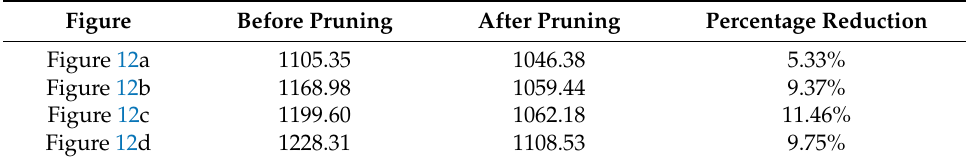
Figure 12. Path planning of the BS-RRT algorithm in common maps and there are 5, 20, 50 and 100 obstacles in ( a – d ) respectively. Table 5. Comparison of path changes before and after pruning with cyclic pruning